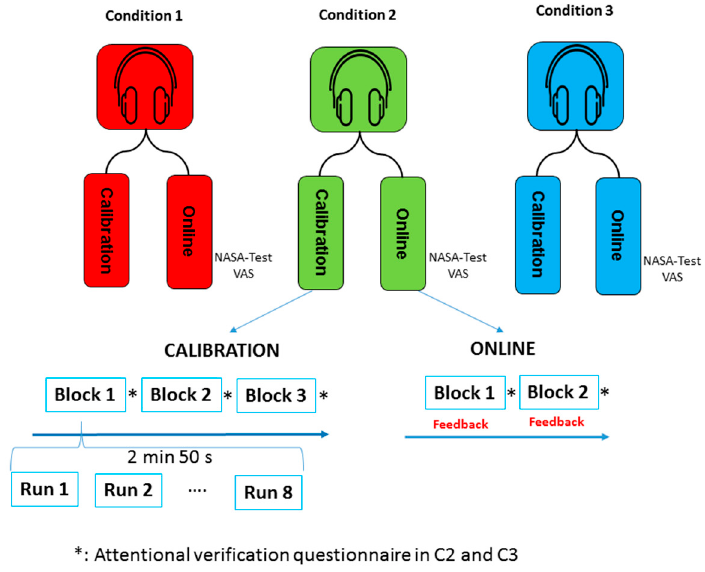
Figure 2. Experimental protocol. Each condition consisted of three calibration and two online blocks. Each block consisted of 8 runs (2 min 50 s for the calibration sessions, and shorter for the online sessions). The attentional verification questionnaires were provided at the end of each block only for conditions C2 and C3.